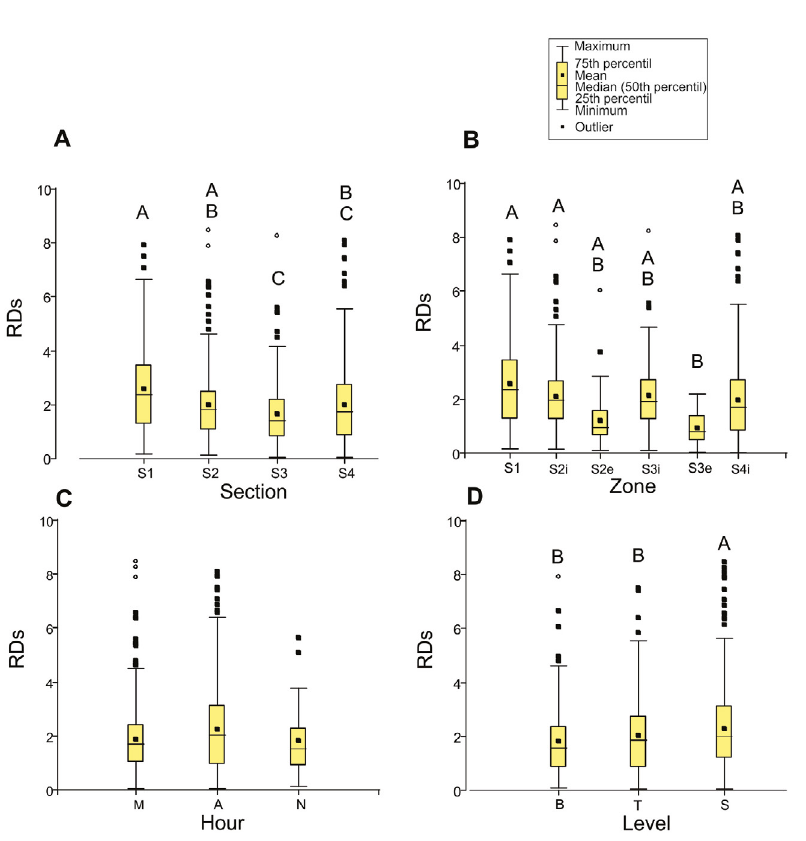
Fig. 4. – Box plot of the standardized RNA/DNA index (RD) for larvae of the anchovy Engraulis anchoita , according to (A) oceanographic section (S1-S4), (B) oceanographic section grouping the internal and external stations in relation to the position of the tidal front (S1, S2i, S2e, S3i, S3e, S4), (C) time of day (M, morning; A, afternoon; N, night), (D) depth (B, bottom; T, thermocline; S, surface). Different letters on the bars indicate significant differences in